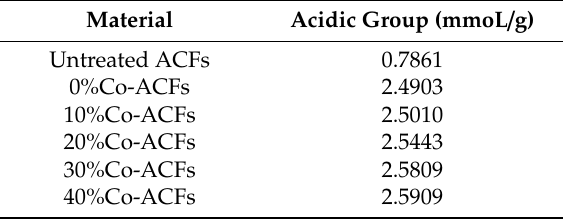
Table 2. Content of oxygen functional groups on ACFs surface before and after cobalt loading.